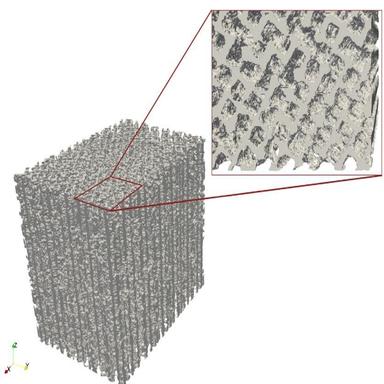
Specimen 300: Voxel model after segmentation.